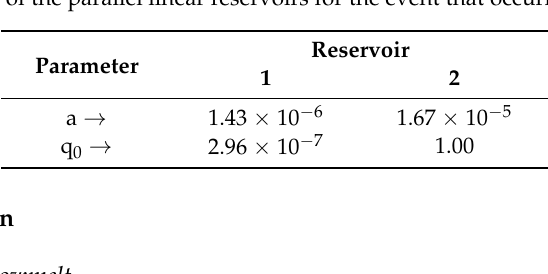
Table 3. Parameters of the parallel linear reservoirs for the event that occurred in the Esca river.